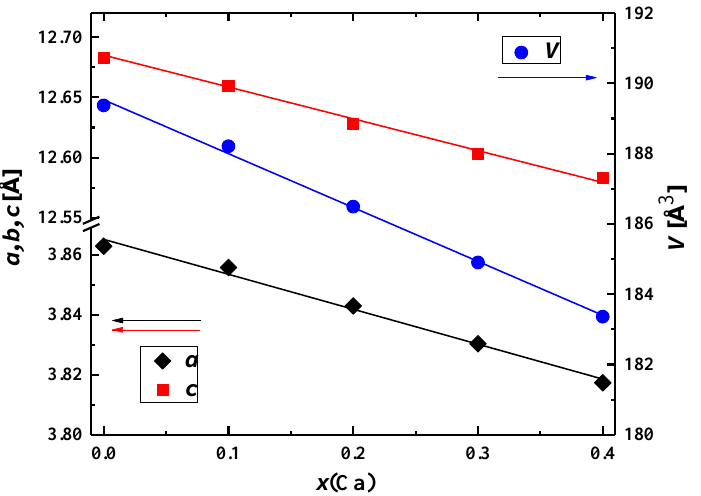
Figure 2. Ca content dependences of unit cell parameters and volume for the La 2 − x Ca x NiO 4+ δ samples according to the Rietveld refinement of the XRD data.